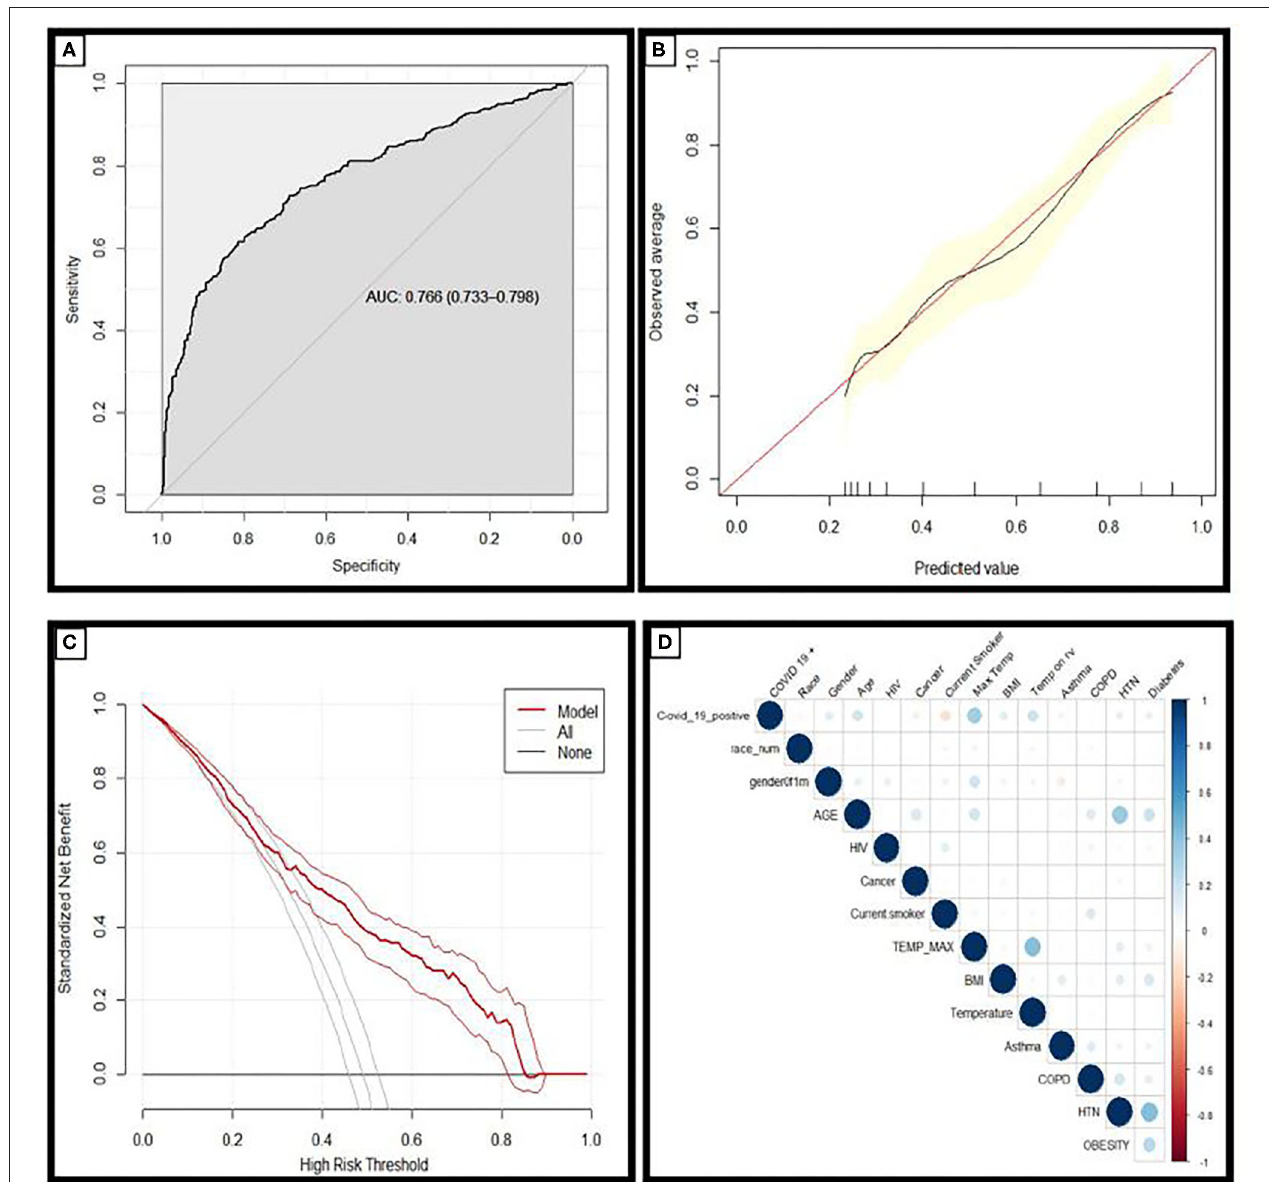
FIGURE 1 | (A) Receiver operating characteristic curves and AUC values for the model in the holdout dataset demonstrating the discriminative ability of this model (AUC = 0.766; 95% CI 0.733–0.798). (B) Calibration curves of the model in the holdout dataset demonstrating the agreement between predicted and observed probabilities of a positive Covid-19 test. (C) Decision curve analysis for positive Covid-19 test prediction in the holdout dataset. (D) Correlation matrix demonstrating the correlation between risk factors and COVID-19 diagnosis: the larger the size, and the stronger the color, the higher the